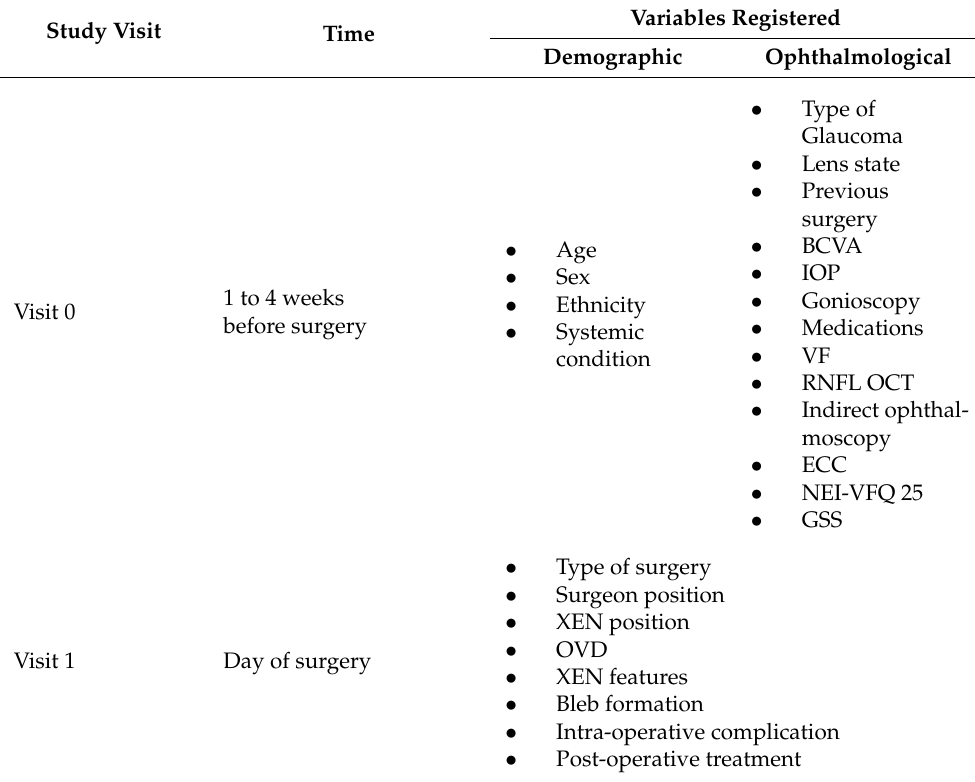
Table 1. Reporting form recording the study visits and variables registered at